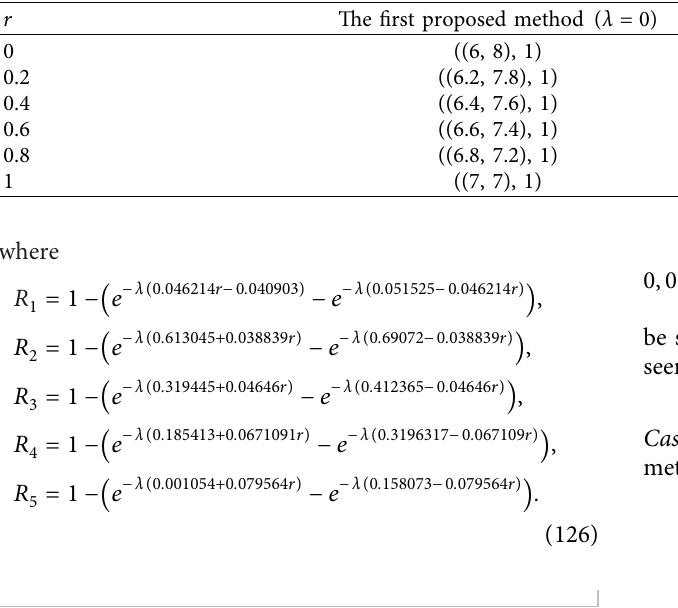
Table 11: Comparison of 􏽥 u